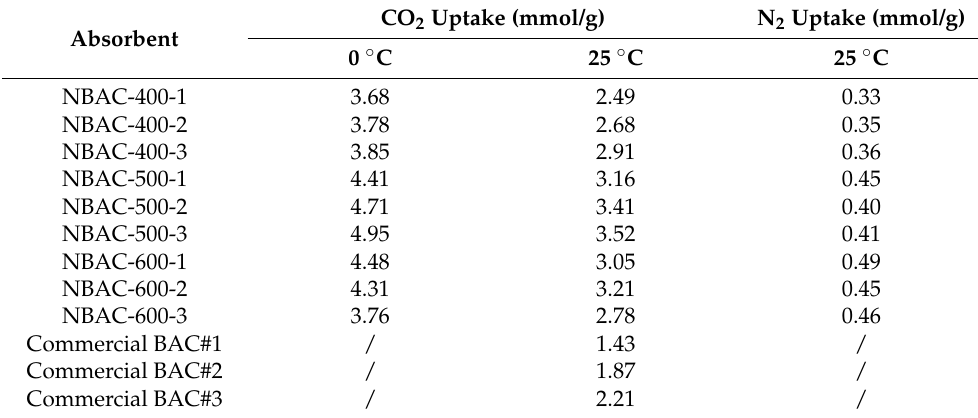
Figure 4. Adsorption isotherms of CO 2 ( a ) and N 2 ( b ) for NBACs synthesized at 500 °C. Table 3. CO 2 and N 2 adsorption capacity for NBACs at 1 bar, at 0 ◦ C and 25 ◦